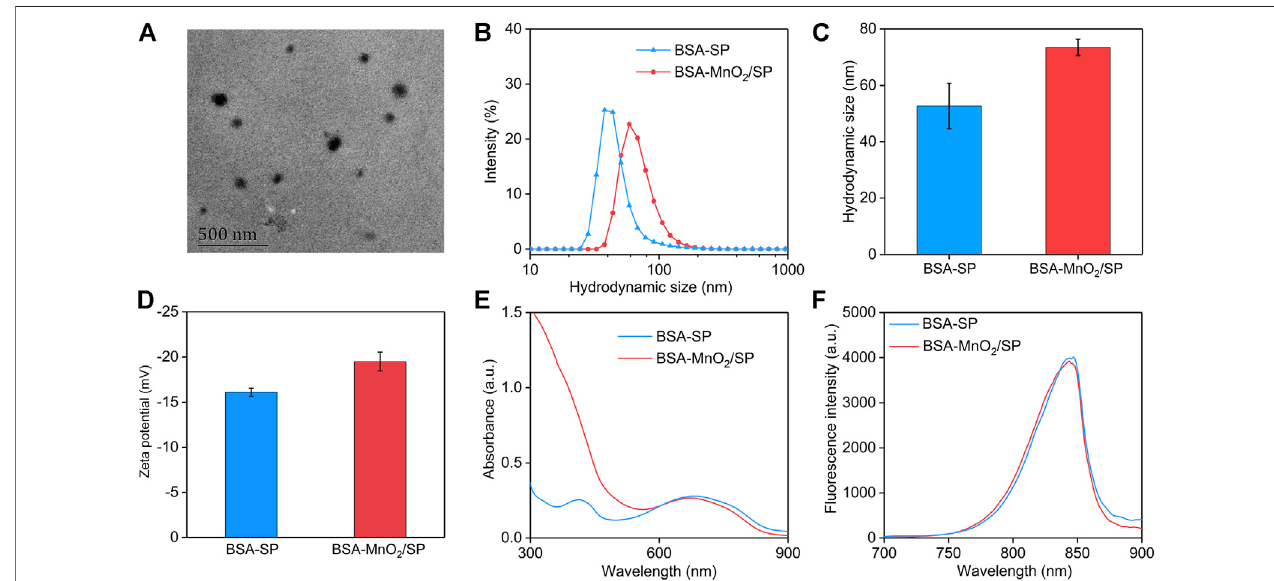
FIGURE 2 | Preparation and characterization of BSA-MnO 2 /SP nanocomposites. (A) Representative TEM image of BSA-MnO 2 /SP nanocomposites. (B) DLS pro fi les of BSA-SP nanoparticles and BSA-MnO 2 /SP nanocomposites. (C) Hydrodynamic sizes of BSA-SP nanoparticles and BSA-MnO 2 /SP nanocomposites measured using DLS. (D) Zeta potentials of BSA-SP nanoparticles and BSA-MnO 2 /SP nanocomposites. (E) Absorbance spectra of BSA-SP nanoparticles and BSA- MnO 2 /SP nanocomposites. (F) Fluorescence spectra of BSA-SP nanoparticles and BSA-MnO 2 /SP